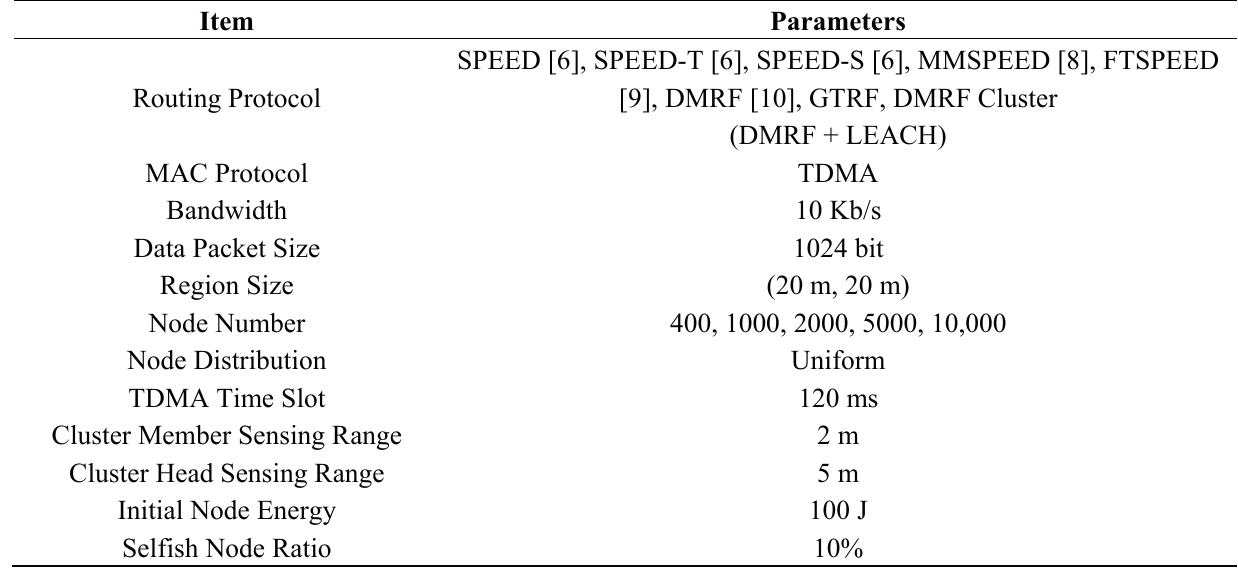
Table 2. Simulation